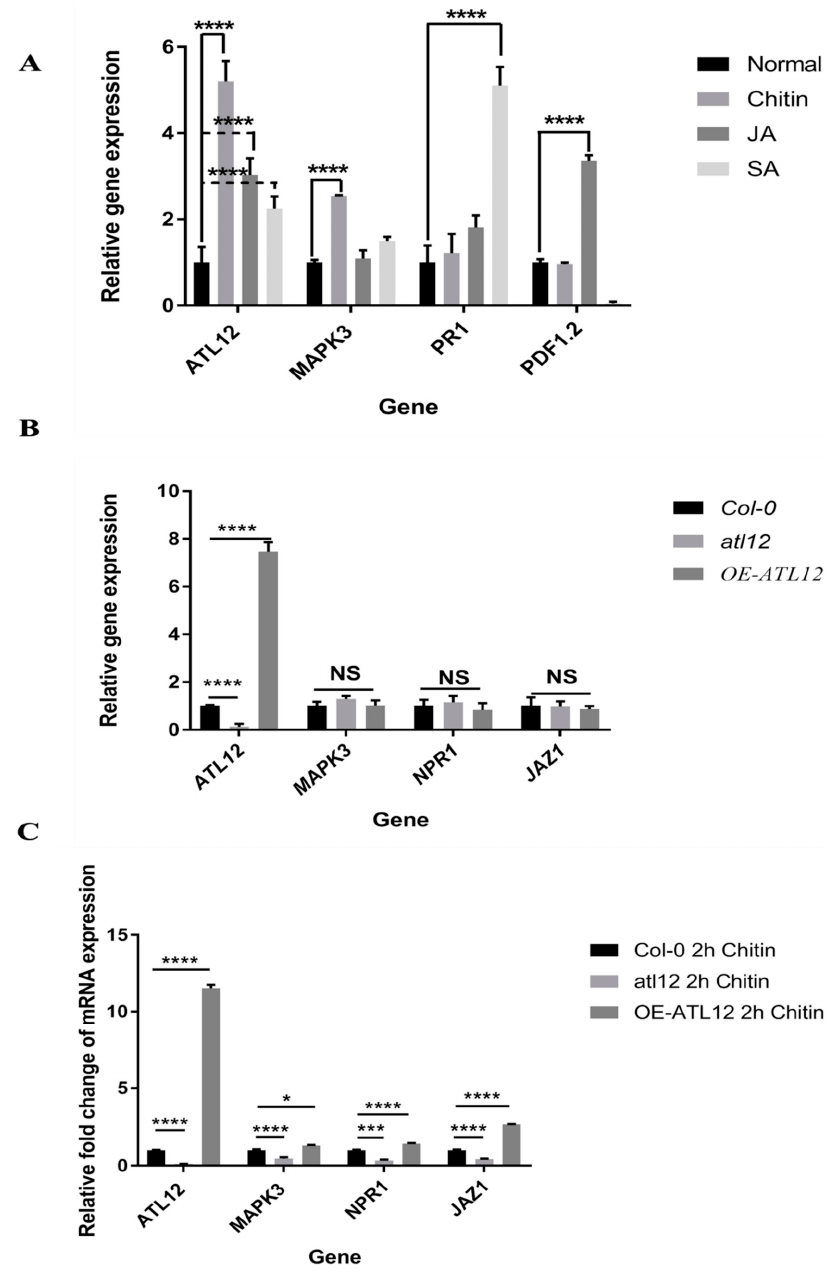
Figure 8. Influence of SA-, JA-, and Chitin-mediated pathways on ATL12 expression ( A ). qRT-PCR analysis of marker gene expression in response to 100 mg/mL chitin, 100 μ M MeJA, and 2 mM Salicylic acid for 2 h and ATL12, internal control beta-actin and marker genes for each signaling pathway were determined. ( B ). qRT-PCR analysis of marker gene expression under normal conditions. ( C ). qRT-PCR analysis of marker gene expression in response to 100 mg/mL chitin for 2 h and ATL12, internal control beta-actin and marker genes for each signaling pathway expression were determined. NS indicated no significance. Asterisks indicate statically significant differences between the samples treated and untreated, according to the One-way ANOVA analysis and multiple comparisons post- Tukey’s test. The whole experiments were repeated three times. **** indicated p < 0.0001, *** indicated p < 0.001, and * indicated p <